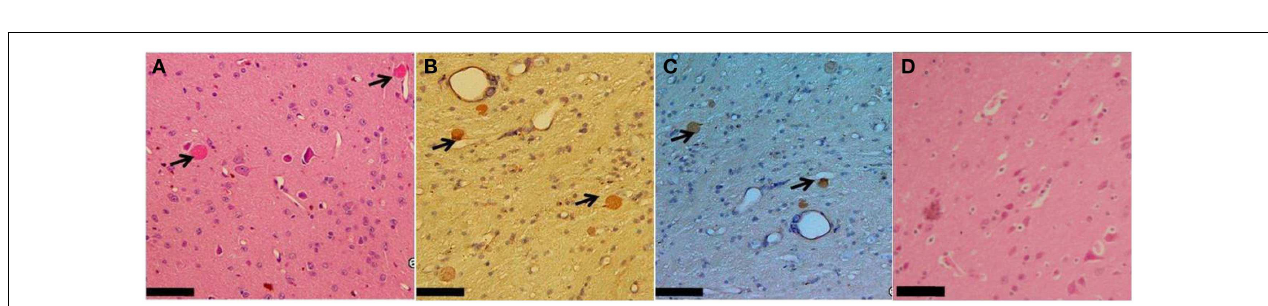
FIGURE 1 | (A) Brain section from the temporal lobe of a memory-affected animal (subjectT3311) treated with a polyclonal serum against human A β 42 and stained with DAB.The inset picture is a photomicrograph control treated